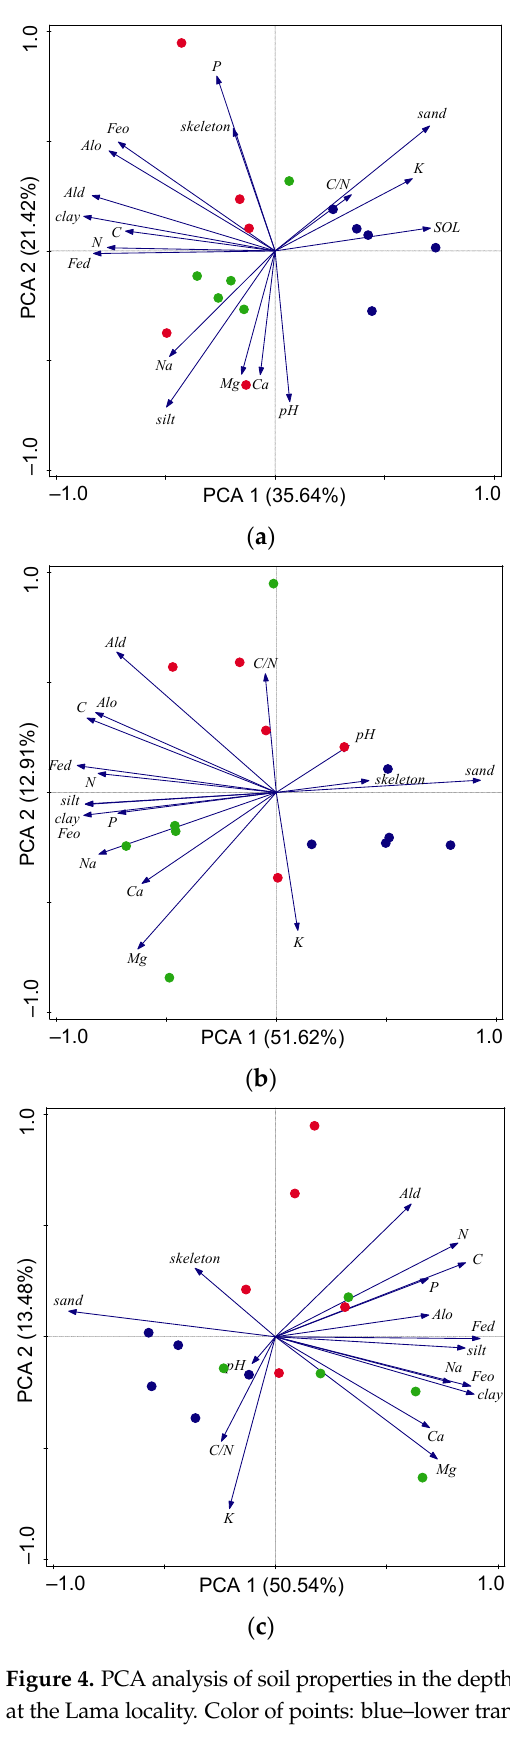
Figure 4. PCA analysis of soil properties in the depth of soil ( a ) 0–0.1 m, ( b ) 0.1–0.2 m, and ( c ) 0.2–0.3 m at the Lama locality. Color of points: blue–lower transect, green–middle transect, red–upper transect.